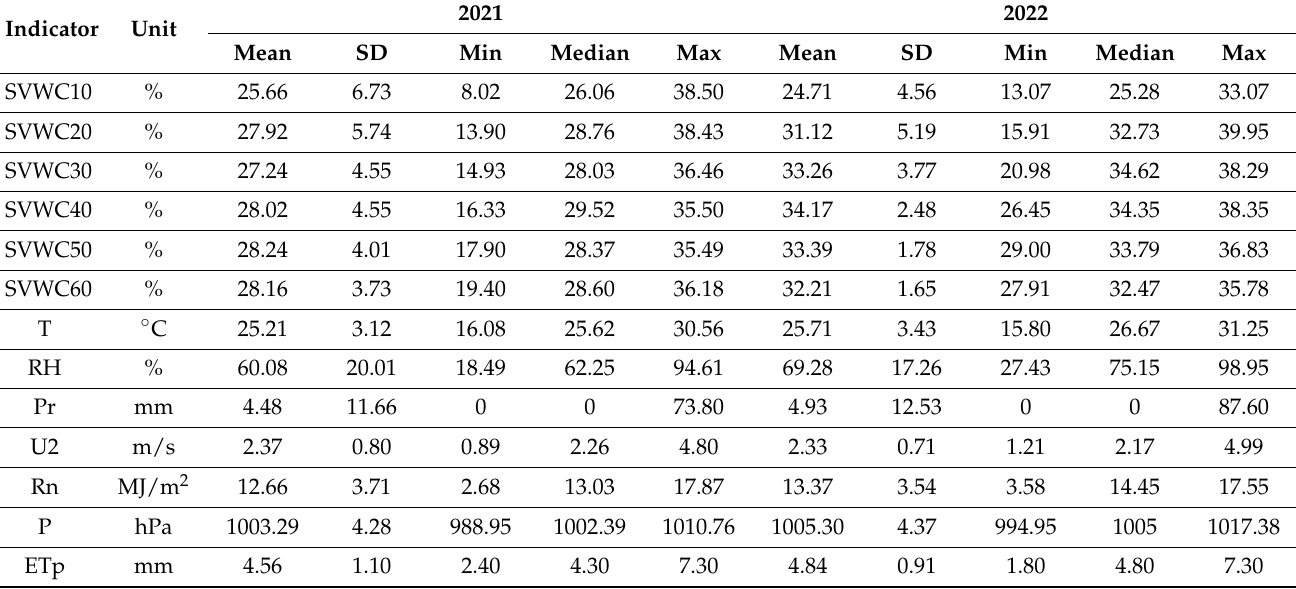
Table 7. Statistics of the environmental indicators in the maize growing areas.